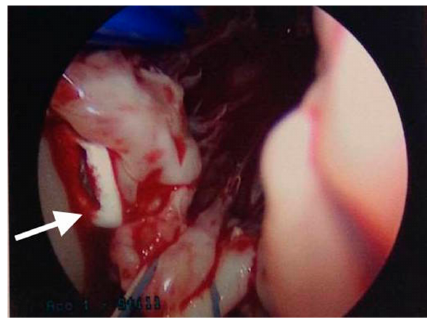
Figure 3. Intra ‐ operative image showing linear, smooth elongated PMMA cement in the left ventricle (white arrow).